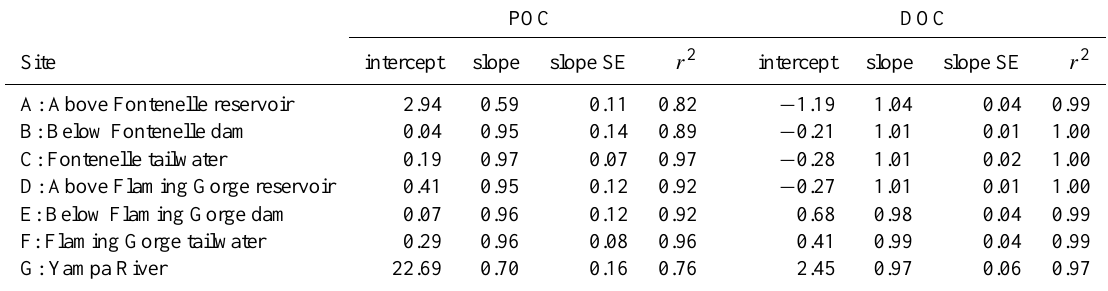
Table 2. Select model statistics from linear regression (lm in R; R Development Core Team, 2015) models to compare predicted organic carbon fluxes to observed particulate organic carbon (POC) and dissolved organic carbon (DOC) fluxes (Flux d , td − 1 ) for each sampling site. Predicted organic carbon fluxes were calculated from estimated daily organic carbon (POC or DOC) concentrations ([OC]) and discharge ( Q ). Linear regression models were used to predict [OC] where ln[OC] = β 0 + β 1 ln[ Q ] + β 2 ln[ Q ] 2 , except for sites below Flaming Gorge dam where there was no statistical relationship between DOC and Q . Average measured DOC and discharge were used to estimate daily DOC fluxes for sites below Flaming Gorge dam. Observed OC fluxes were calculated multiplying the mean measured [OC] and corresponding mean daily Q . Letters A–G preceding the site names correspond to sites A–G in Fig.